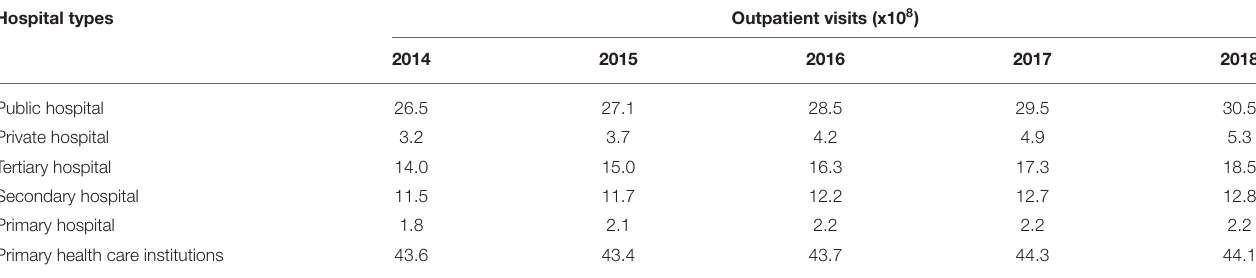
TABLE 1 | Hospital outpatient visits: China,